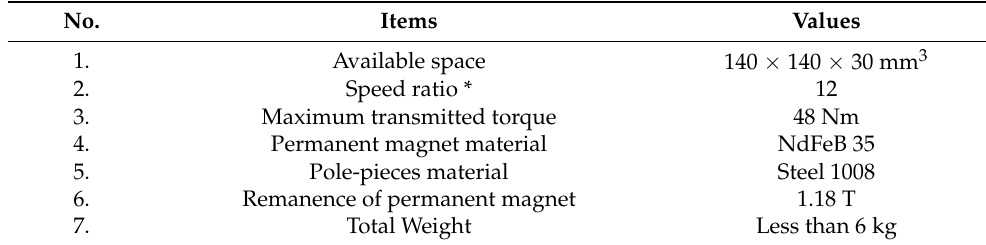
Table 1. Design specifications of the